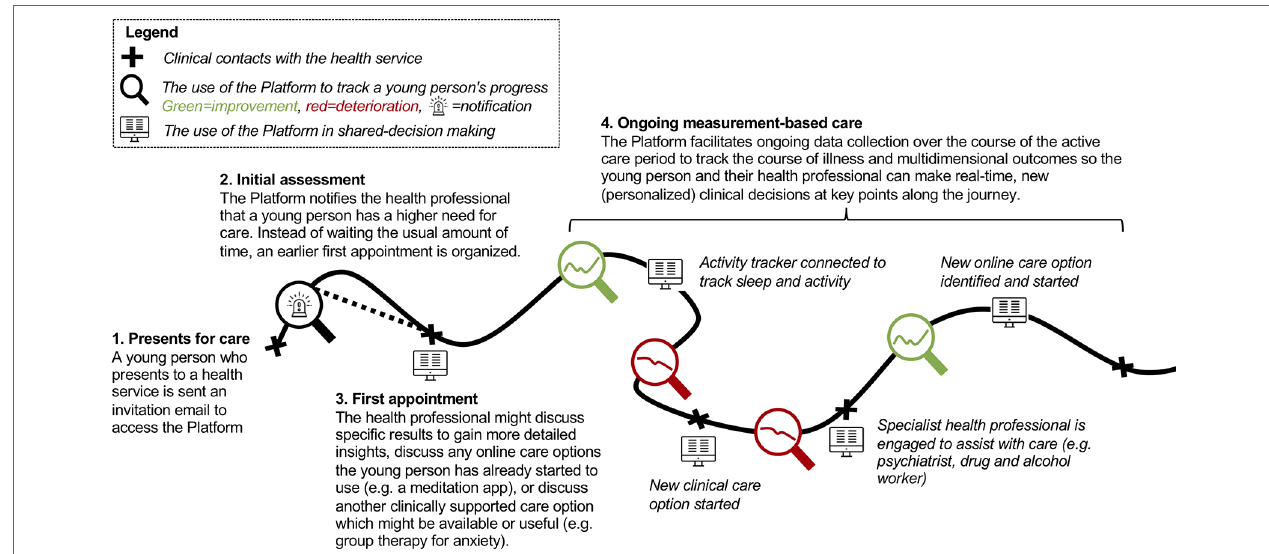
FIGURE 3 | Illustrative example of a young person’s journey through care. The figure shows how the Platform can be used at different points along the care journey to facilitate measurement-based care to drive personalized treatment decisions. Specifically, in this example, the Platform is being used at entry to care to identify young people reporting higher levels of suicidality, who may need to “skip” the waitlist. The first appointment (much like proceeding clinical contacts) can be used to engage in usual face-to-face clinical care or enhanced by the Platform enhanced by the Platform (as described in point 3 above). As care progresses, ongoing data collection and tracking are used to make personalized treatment decisions, such as connecting to an activity tracker to better understand a young person's sleep wake cycle in relation to their mood, start a new clinical intervention or engage a specialist due to a deterioration in outcomes, or engage in an online intervention when outcomes start to improve. “Computer” by Nikita Kozin from the Noun Project; “Alarm” icon made by Freepik from